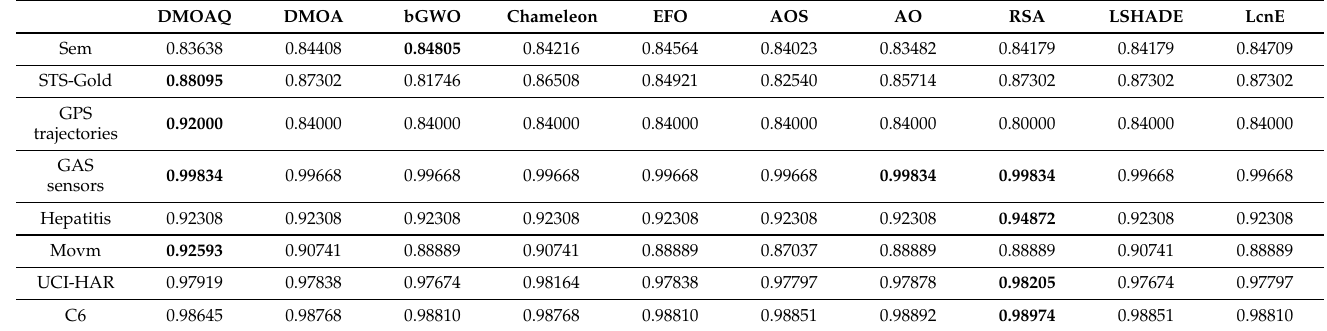
Table 13. Specificity obtained from competitive algorithm for all